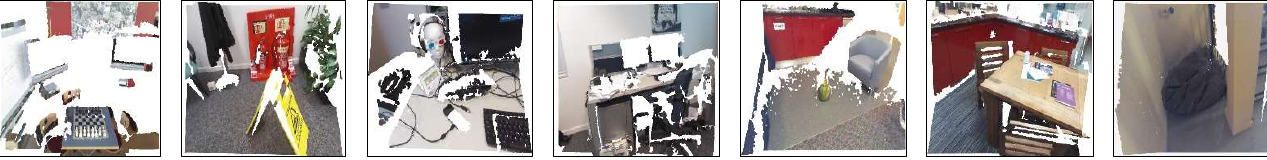
Figure 7. Objects selected for evaluation, include Chess, Fire, Heads, Office, Pumpkin, Red Kitchen, and